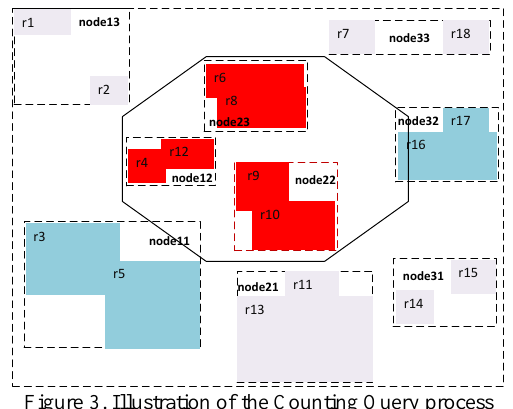
Figure 3. Illustration of the Counting Query process Figure 3 is an illustration of the Counting Query process. In Fig. 3, the polygon of black solid line is the given query polygon. Polygons r1 to Polygon r18 are to be retrieved. First, execute query operation on all subtrees and find out polygons intersecting the query region. MBRs of node12, node22 and node23 are completely covered by the query polygon. Therefore, there is no need to perform intersect calculation for these three nodes. MBRs of Node11 and node32 intersect with the query polygon. So the intersect calculation should be performed for these two nodes. Say the naming rules of regionID for each node is “id_”+nodename, in this case the results cached to Redis is (query polygon, [(id_node12,2), (id_node22,2),(id_node23,2),(id_node32,2)].